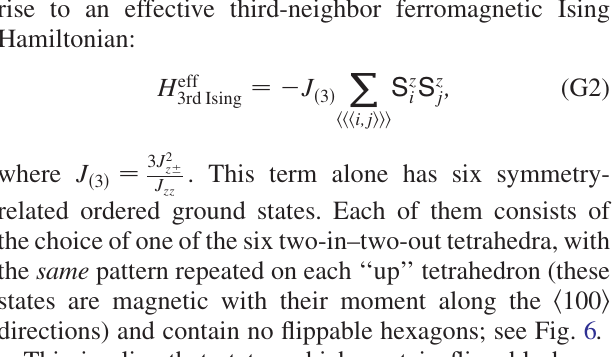
FIG. 6. One of the six ground states of H eff P S z S z (cid:3) 3 J 2 z (cid:4) . A blue sphere represents an ‘‘in’’ spin while hhh i;j iii i j J zz a black sphere represents an ‘‘out’’ one. Because two of the four chain types contain nonalternating spins, there are no flippable hexagons in any of the six (equivalent) ground